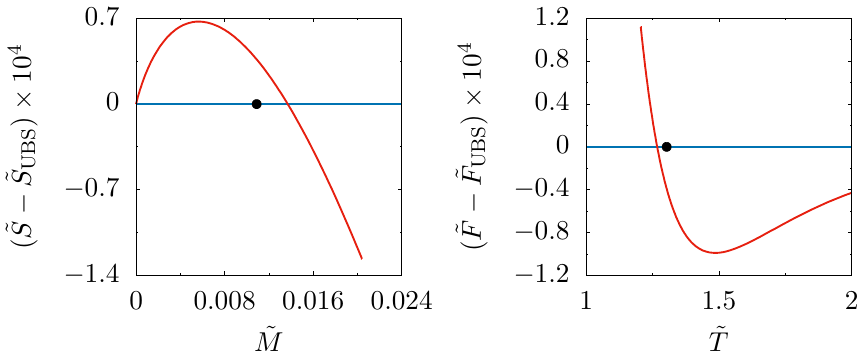
Figure 1 . Phase diagram of 10-dimensional localized black holes in the microcanonical (left) and canonical (right) ensemble. We plot the di(cid:11)erence of entropy and free energy, respectively, to the corresponding values of the uniform black string, which is thus represented as the blue zero line in these diagrams with the black circle indicating the solution where the Gregory-La(cid:13)amme instability arises. The branch of localized black holes, represented by the red line, is thermodynamically favored over the uniform black strings for small masses or high